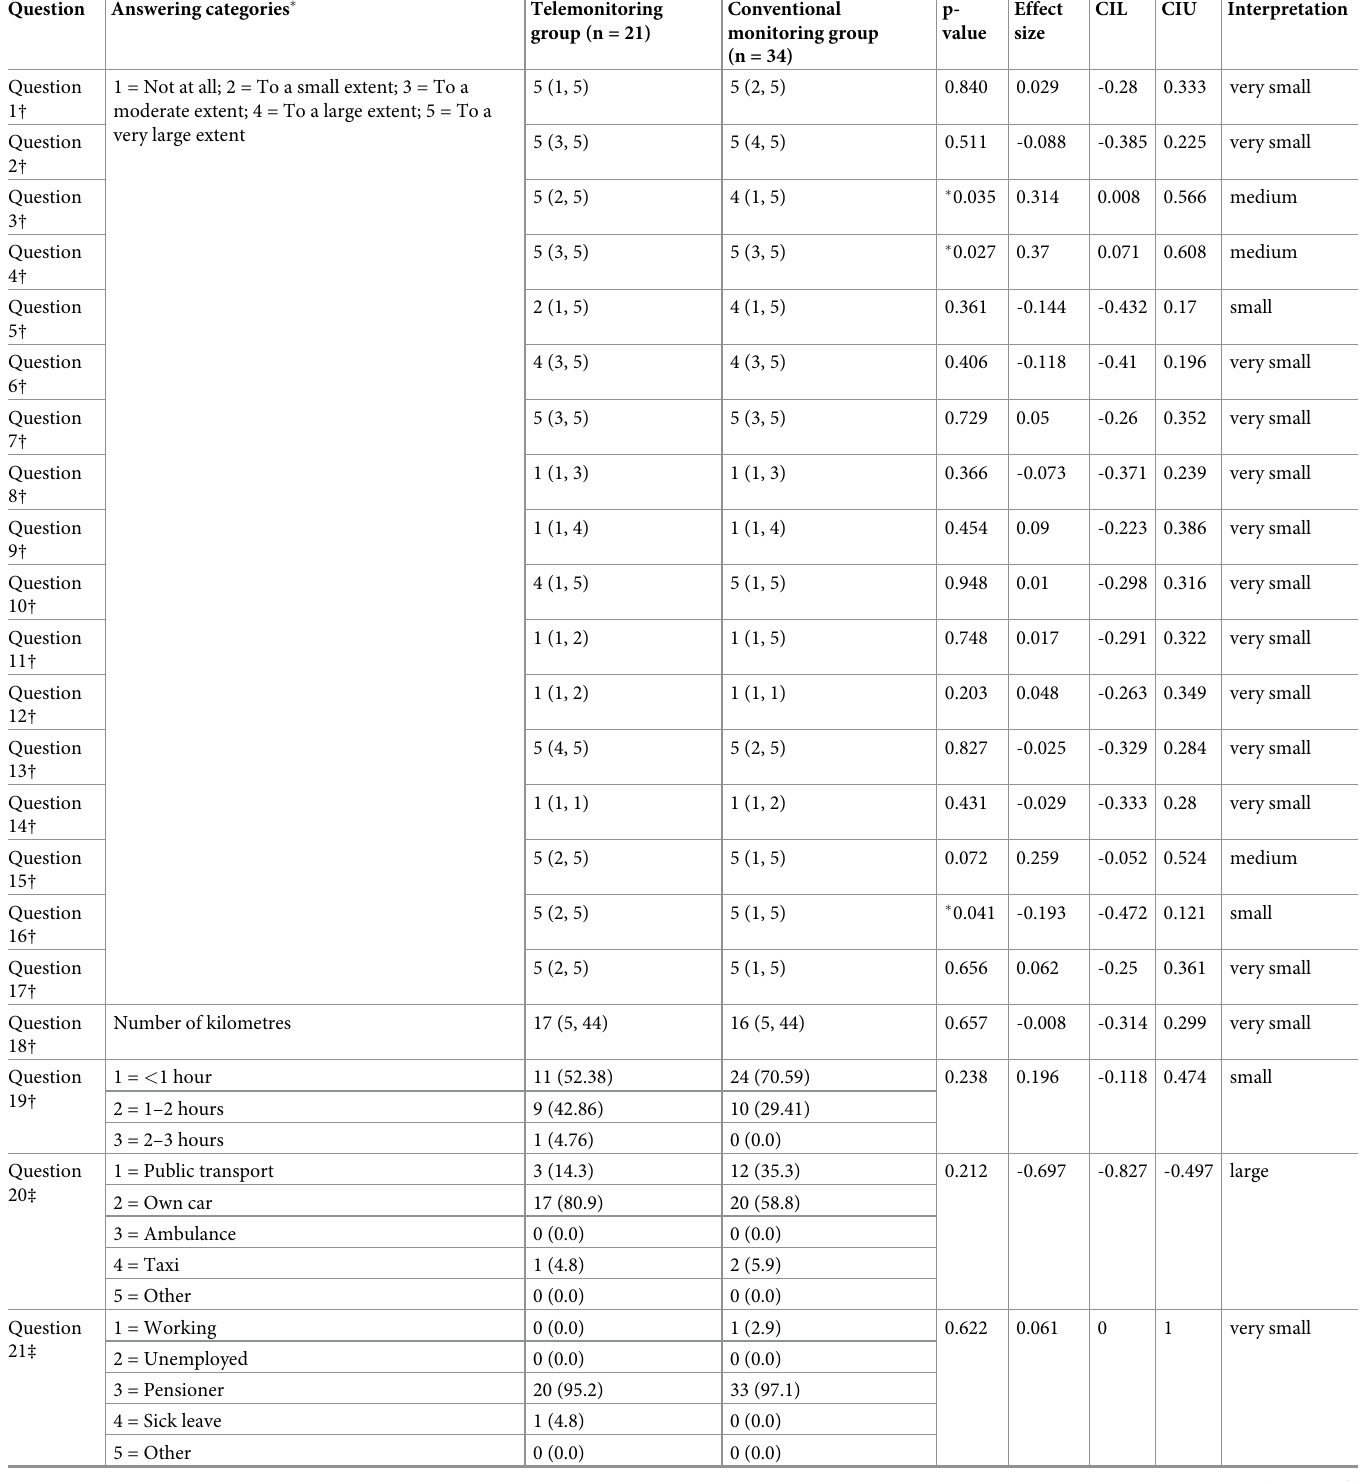
Table 3. Results derived from the